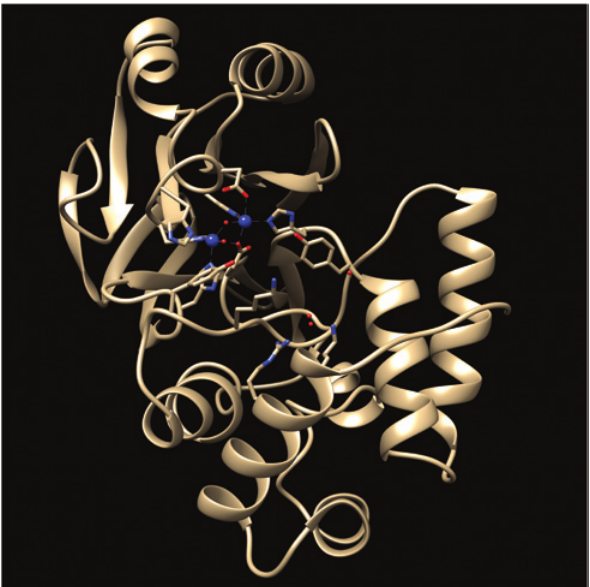
Figure 8: X-ray structure of the H. sapiens Glo2 with the binuclear Zn 2 + atoms shown as blue spheres (PDB: